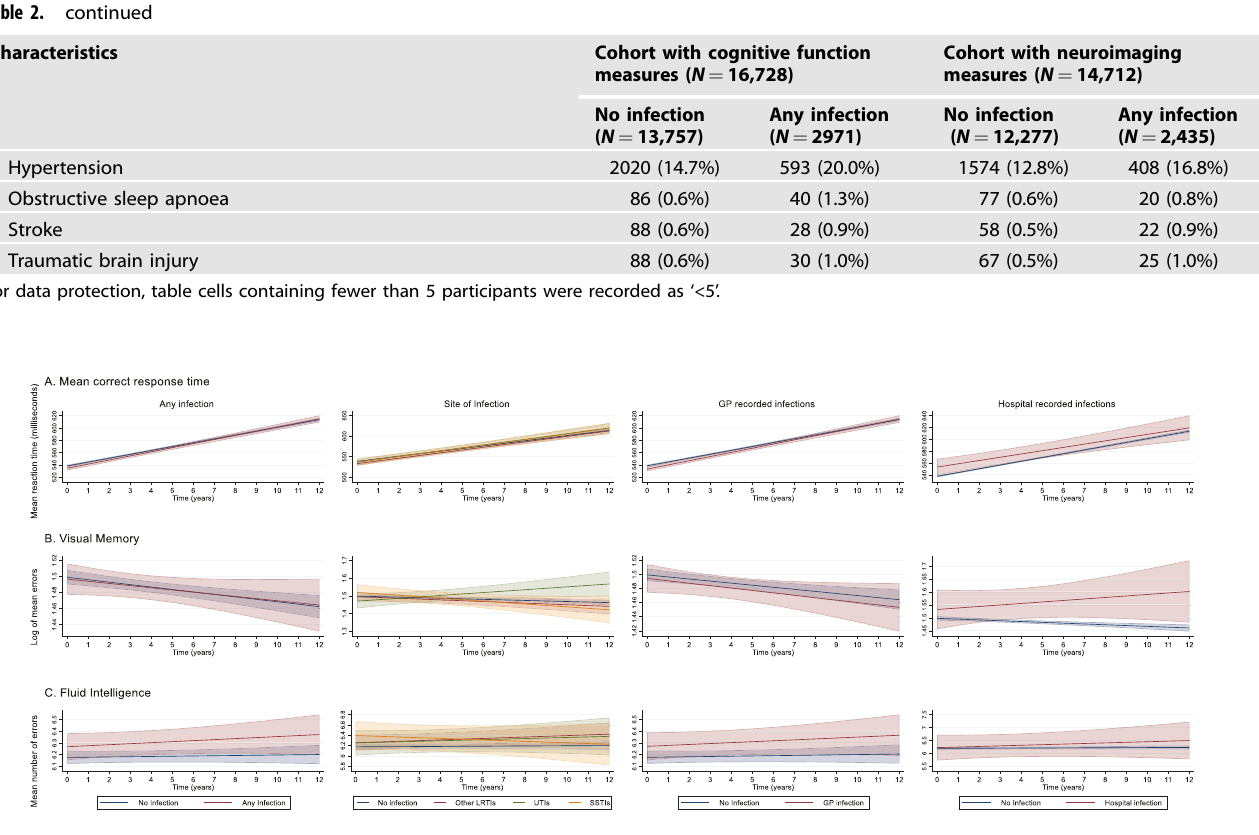
Fig. 2 Association of presence, site and setting (GP and hospital) with changes in cognitive performance over follow-up. Linear mixed models with random intercept and slope used to illustrate fi tted changes in cognitive function over time for the mean correct response time, visual memory (log transformed) and fl uid intelligence test. A Mean correct response time models adjusted for age (years), sex, time, baseline test score, interaction term with time × infection status, ethnicity, BMI, years in full-time education, physical activity, alcohol consumption, diabetes, anxiety and depression, COPD, multiple sclerosis, hypertension and heart failure. B Visual memory models adjusted for age (years), sex, time, baseline test score, interaction term with time × infection status, ethnicity, BMI, smoking status, socioeconomic deprivation, physical activity, alcohol frequency, years in full-time education, diabetes, anxiety and depression, COPD, hypertension, in fl ammatory bowel disease, rheumatoid arthritis, obstructive sleep apnoea, and multiple sclerosis. C Fluid intelligence models adjusted for age (years), sex, time, baseline test score, interaction term with time × infection status and years in full-time